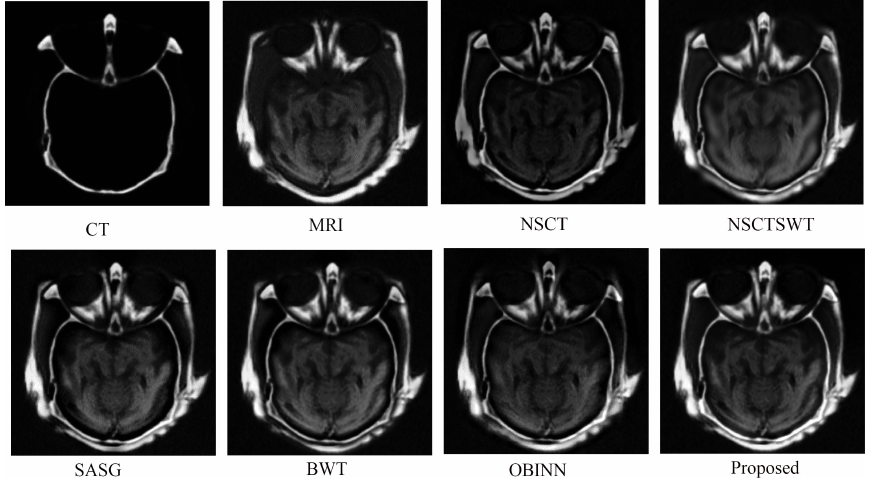
Fig. 3. CT and MRI images of the normal brain stem and the fusion results.